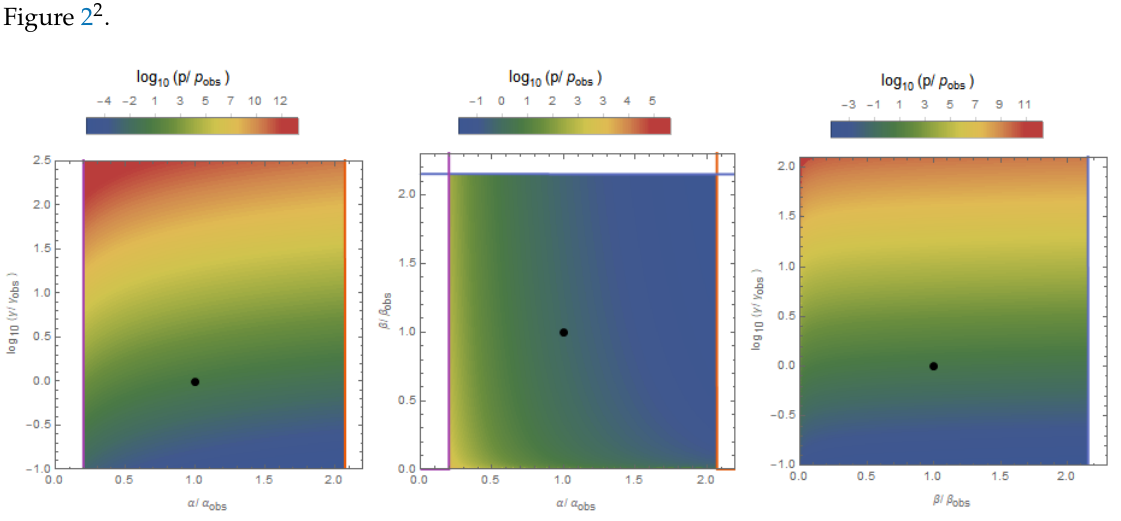
Figure 2. The distribution of stars throughout the multiverse. Each point represents a universe with a given set of parameters; the black dot represents our values. A strong preference for large γ , weak preference for small β , and a slightly stronger preference for small α value can be seen. Note that the γ axes are logarithmic, as well as the color display for the probability, which spans 16 order of